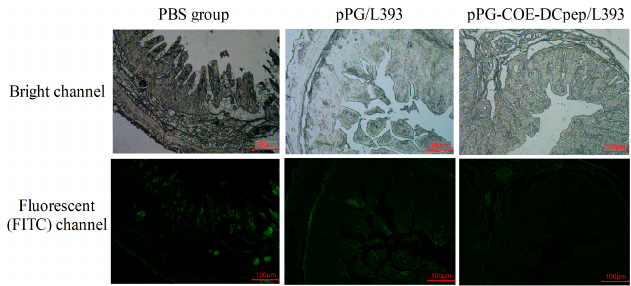
Figure 6. PEDV distribution in the jejunum. The piglets were orally infection with PEDV (1 × 10 6 PFU/mL) via oral-gastric gavage. The PEDV distribution patterns were detected in the villous by an immunofluorescence assay using rabbit polyclonal antibody against PEDV. The top pictures are from the light channel, and the bottom pictures are from the fluorescent (FITC) channel. T he upper and lower panel were from the same section . The pictures are representative of sections derived from each group.